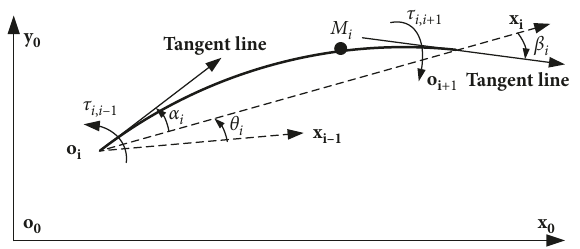
Figure 3: Torques applied at link i